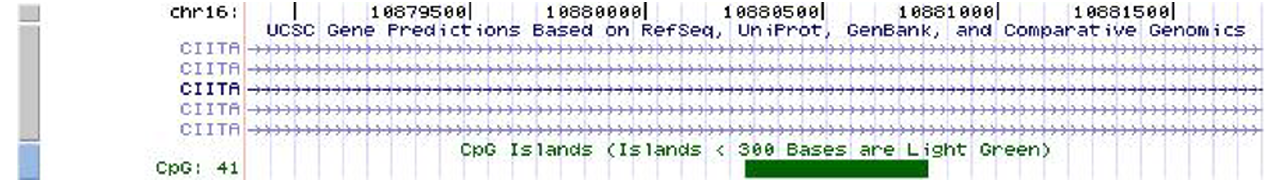
Predicted CpG island in the MHC2TA gene promoter IV